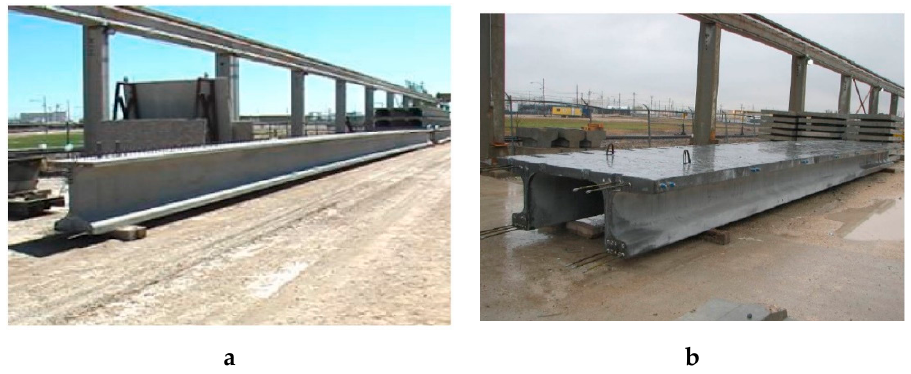
Figure 5. Representative apps of UHPCs in BEs: ( a ) I-formed girder [115]; ( b ) Pi-formed girder